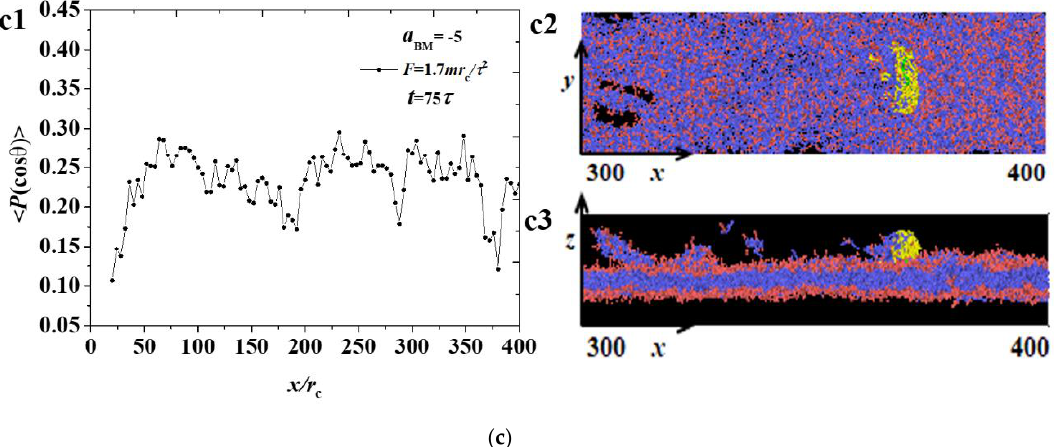
Figure 4. The distribution of order parameters P ( cos θ ) for the phospholipid membrane in the weak adsorption cases of a BM = − 5 and F = 1.7 mr c / τ 2 , where the membrane structures are also displayed. Three time stages, ( a ) t = 0 τ , ( b ) t = 40 τ , and ( c ) t = 75 τ , are demonstrated.